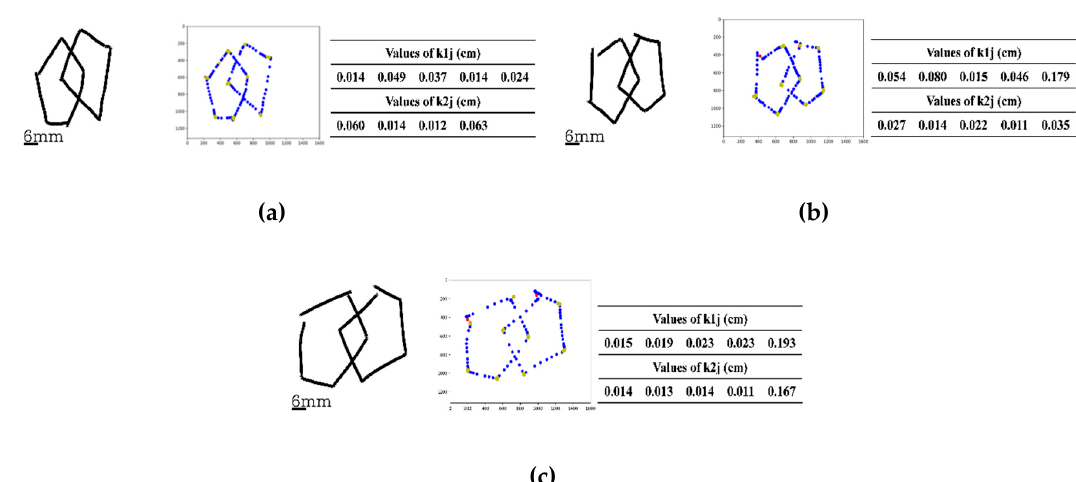
Figure 6. Three examples of openings being detected: ( a ) The case without any openings in both drawn figures. Here, the cluster parameters k 1 j and k 2 j of the left and right-portion figures were 0.014, 0.049, 0.037, 0.014, and 0.024 cm and 0.060, 0.014, 0.012, and 0.063 cm, respectively (all < 0.1 cm). ( b ) The example of a drawing with openings only in the left-portion of the figure. The cluster parameters k 1 j for the left-portion figure were 0.054, 0.080, 0.015, 0.046, and 0.179 cm (thus one > 0.1 cm); however, the cluster parameters k 2 j for the right-portion of the figure were 0.027, 0.014, 0.022, 0.011, and 0.035 cm (all < 0.1 cm). ( c ) The case of openings in both drawn figures with the cluster parameters k 1 j and k 2 j of the left and right figures of 0.015, 0.019, 0.023, 0.023, and 0.193 cm and 0.014, 0.013, 0.014, 0.011, and 0.167 cm, respectively (one for each figure > 0.1 cm).